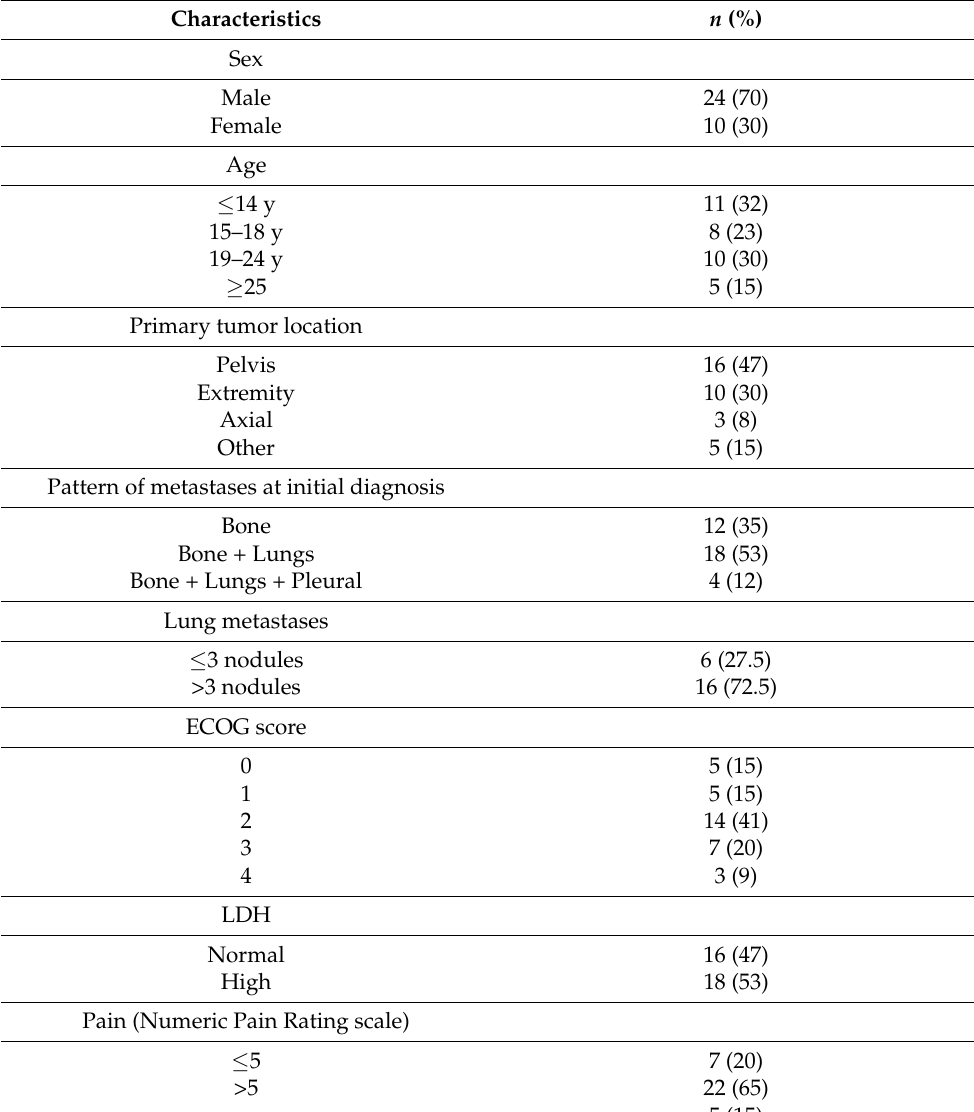
Table 2. Patient